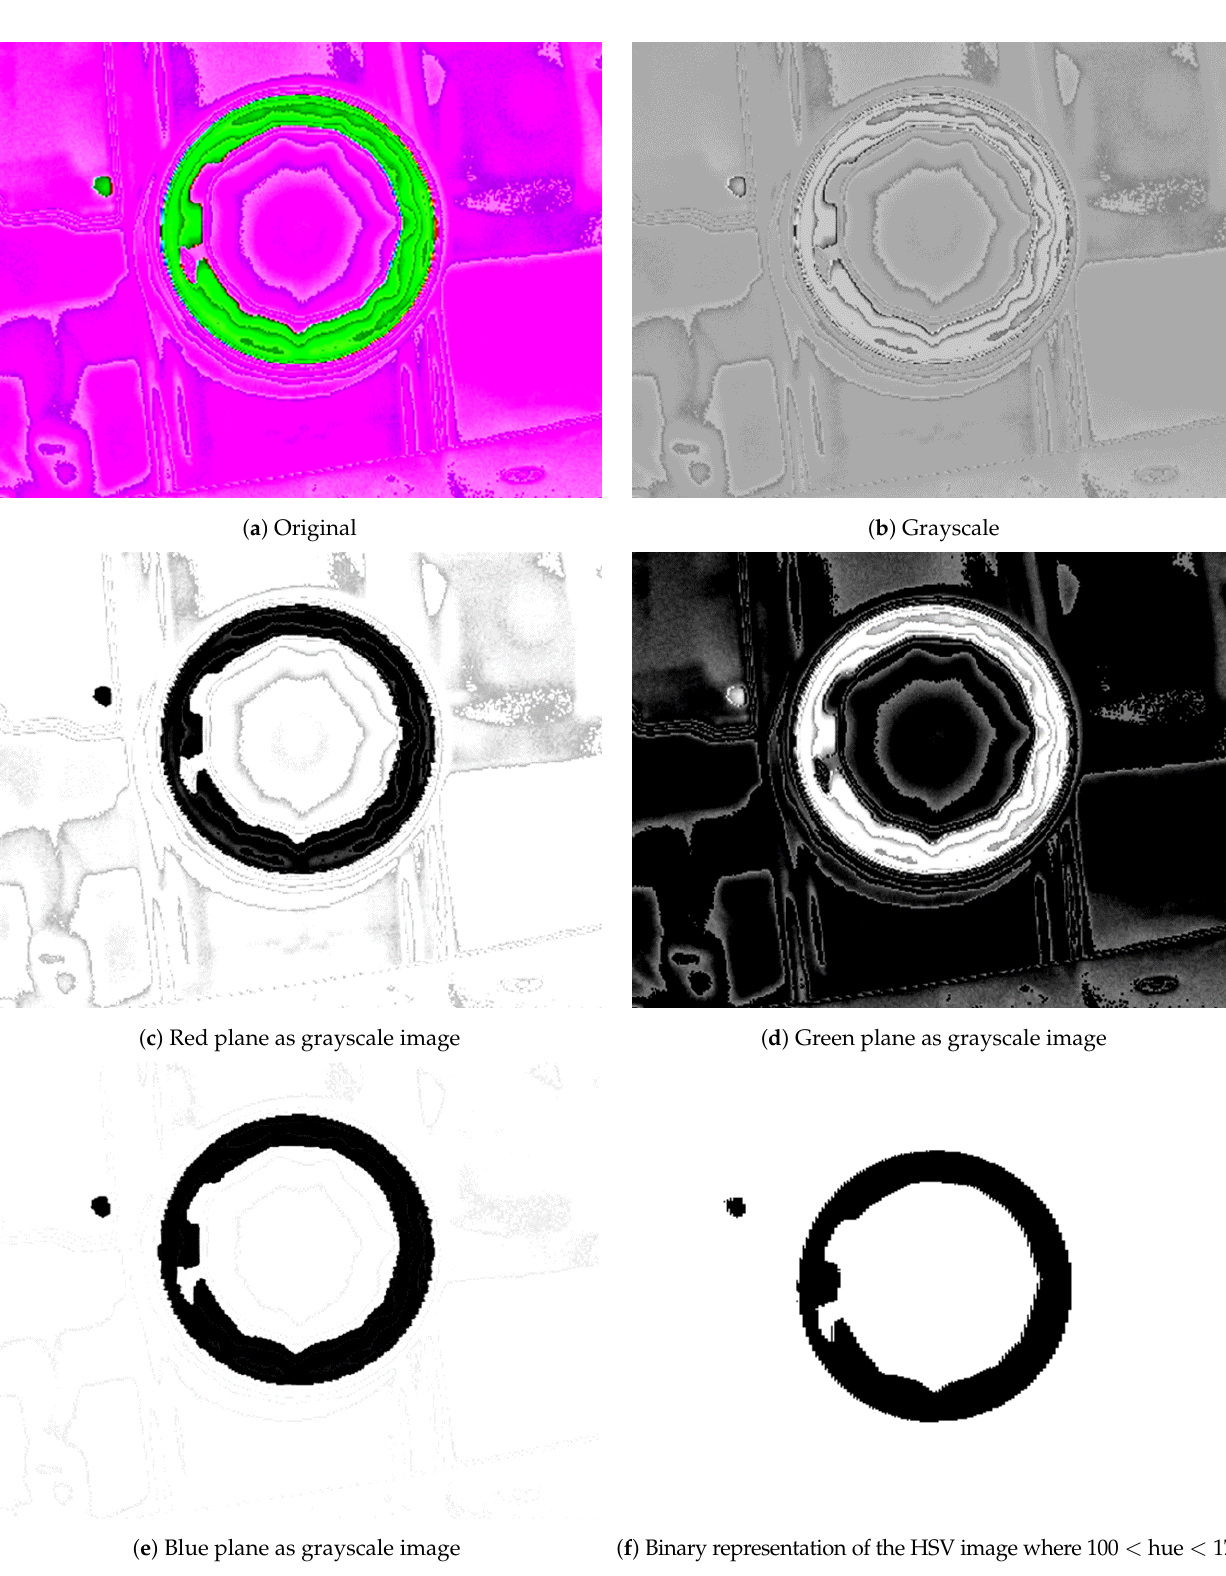
Figure 5. Representation of images using different color